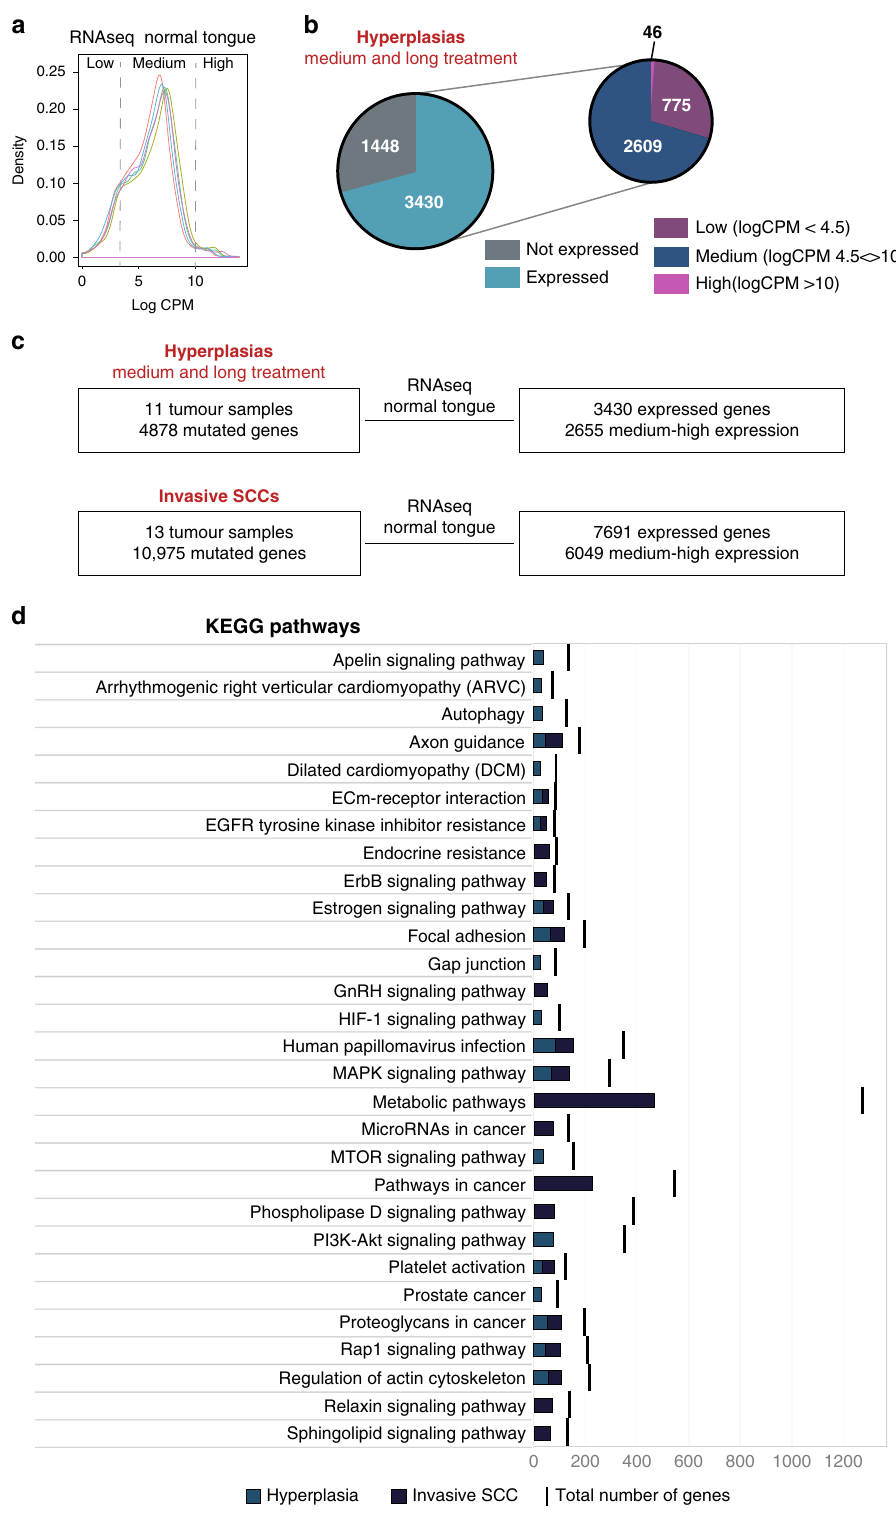
Fig. 4 Functional analysis of the mutations in medium-long treated hyperplasia. a Expression pro fi le (log CPM – Count Per Million normalised read count) of the 5 datasets of normal tongue samples 23 . Graph represents the average of CPM values; x -axis is divided in 3 categories: low, medium and high expression genes. b Pie-chart with the number of expressed genes in each category of genes mutated in hyperplastic samples. c Total number of samples and mutated genes in medium and long-treated hyperplasias and in invasive SCC before (left panels) and after (right panels) fi ltering for the genes medium to highly expressed in the tongue. d Top 10 KEGG pathways enriched in tongue expressed genes mutated in medium and long treated hyperplasias and in invasive SCC. The number of mutated genes in the pathway is indicated as well as the total number of genes in the